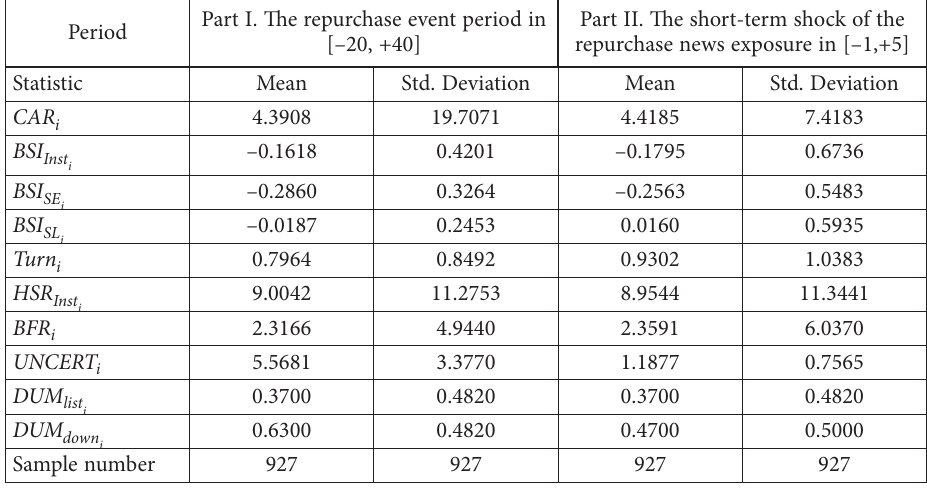
Table 1. Summary of statistics for a sample of 927 in Taiwan’s open-market share repurchase programs